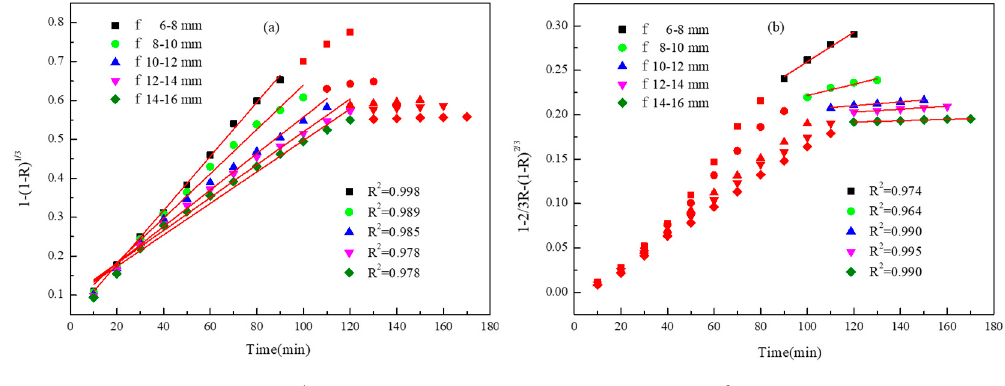
R − ( 1 − R ) 2 3 vs. time ( b ) at 1273 K with Figure 12. Plot of 1 − ( 1 − R ) 1 3 vs. time ( a ) and plot of 1 − 2 (cid:3117) (cid:3118) (cid:2870) 3 (cid:1844) − (1 − (cid:1844)) Figure 12. Plot of 1 − (1 − (cid:1844)) (cid:3119) vs. time ( a ) and plot of 1 − (cid:3119) vs. time ( b ) at 1273 K with (cid:2871) different oxidized VTM pellets diameter in H 2 /(H 2 + CO) = 1/2 atmosphere. different oxidized VTM pellets diameter in H 2 /(H 2 + CO) = 1/2 atmosphere. Table 3. The values of the reduction rate constant at 1273 K with different oxidized VTM pellets